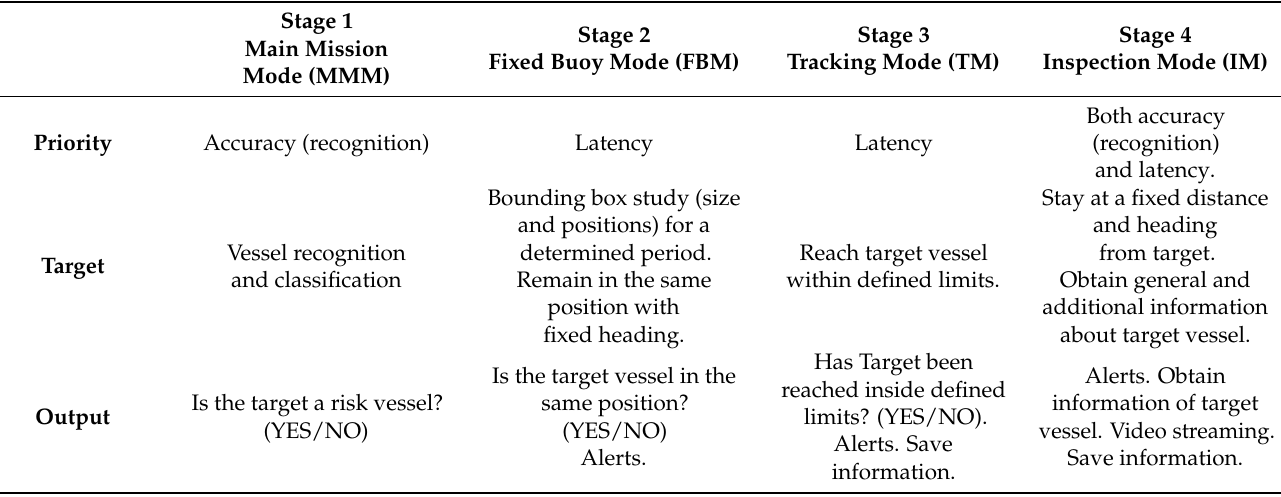
Table 1. Definition of mission